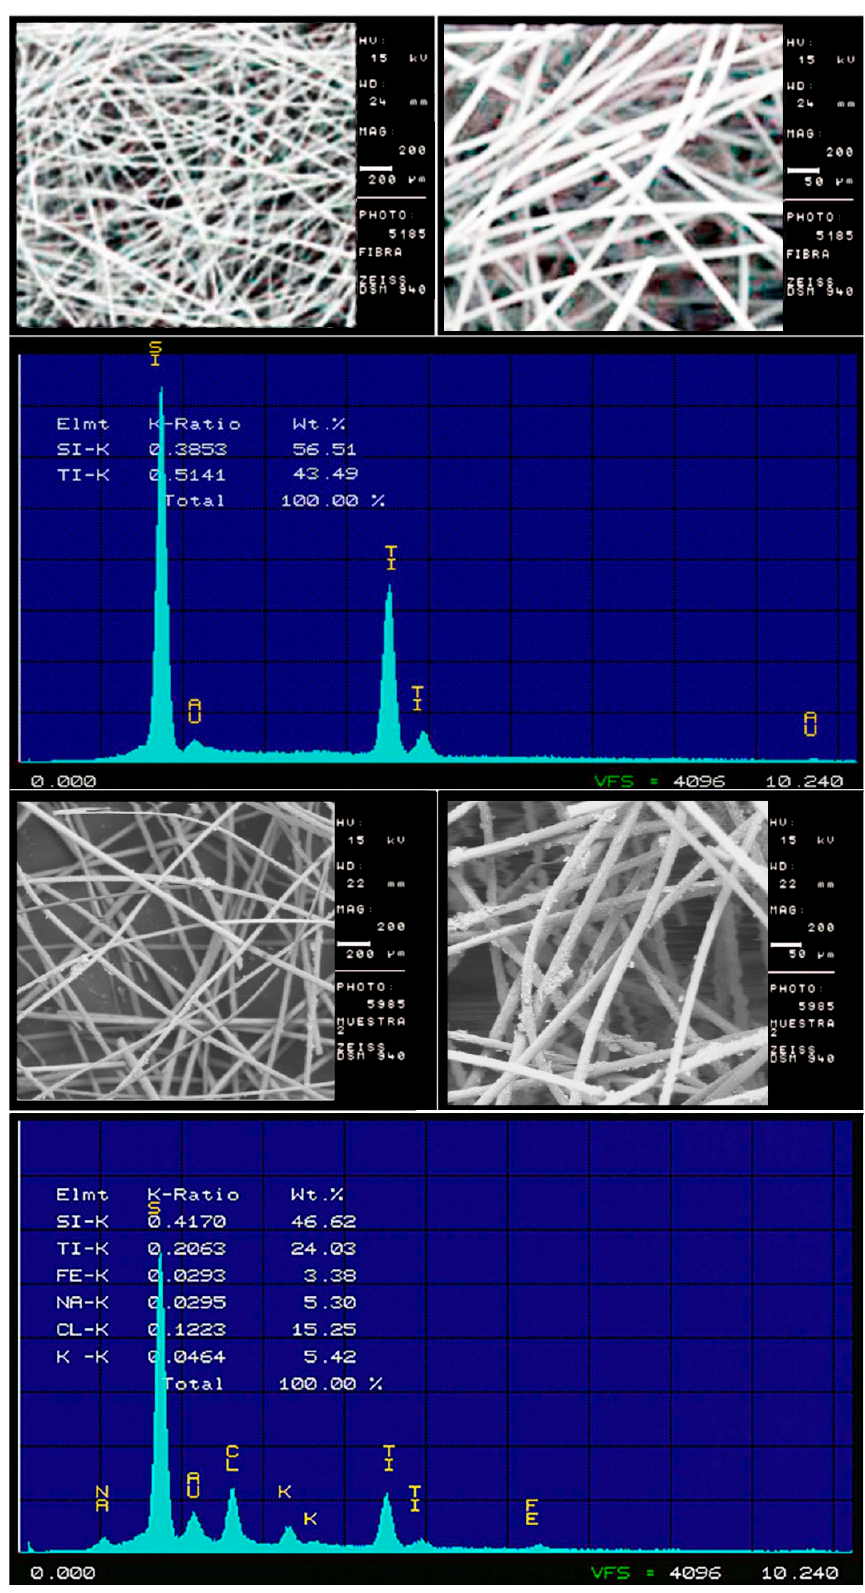
Figure 12. Study of the photocatalytic fiber stability after NH 4+ /NH 3 removal process: 200 and 50 µm scanning electron micrographs and energy dispersive X-ray elemental microanalysis (EDXMA). Upper panel: fiber virgin and lower panel: fiber after NH 4+ /NH 3 removal .